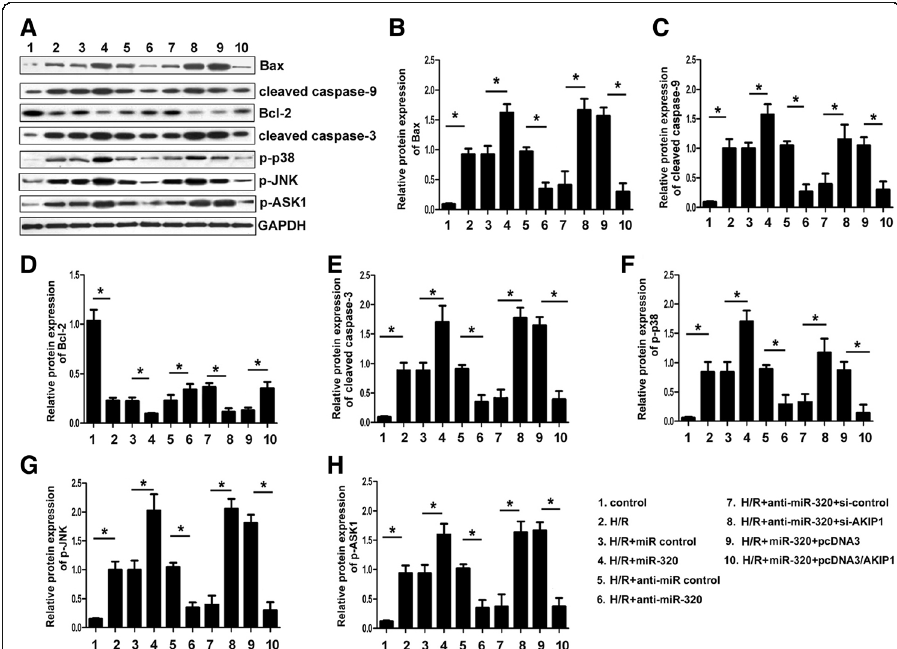
Fig. 6 MiR-320 regulated the expression of Bax, Bcl-2, cleaved caspase-3, cleaved caspase-9, p-ASK1, p-JNK and p-p38 in H9c2 cells after H/R injury by targeting AKIP1. H9c2 cells after H/R injury were transfected with miR-320, miR control, miR-320 and pcDNA3/AKIP1 vector, miR-320 and pcDNA3 control vector, anti-miR- 320, anti-miR control, anti-miR-320 and si-AKIP1, anti-miR-320 and siRNA control, respectively; the effects of miR-320 on cell apoptosis-related genes (Bax, Bcl-2, cleaved caspase-3, cleaved caspase-9, p-ASK1, p-JNK and p-p38) were analyzed by Western blot. * P <